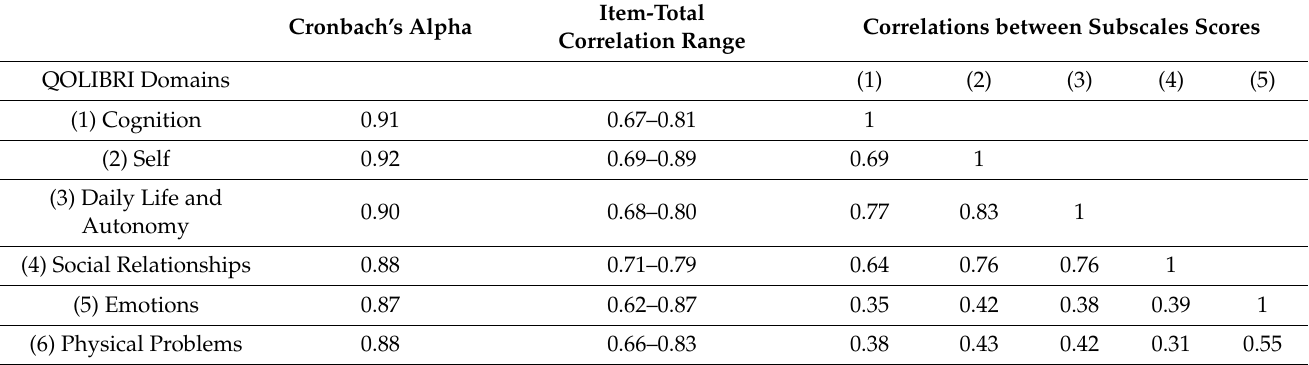
Table 4. Psychometric properties of the QOLIBRI scales in general population.